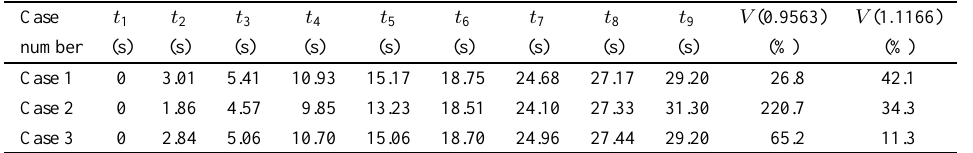
Time location of impulses for shaping the roll torque